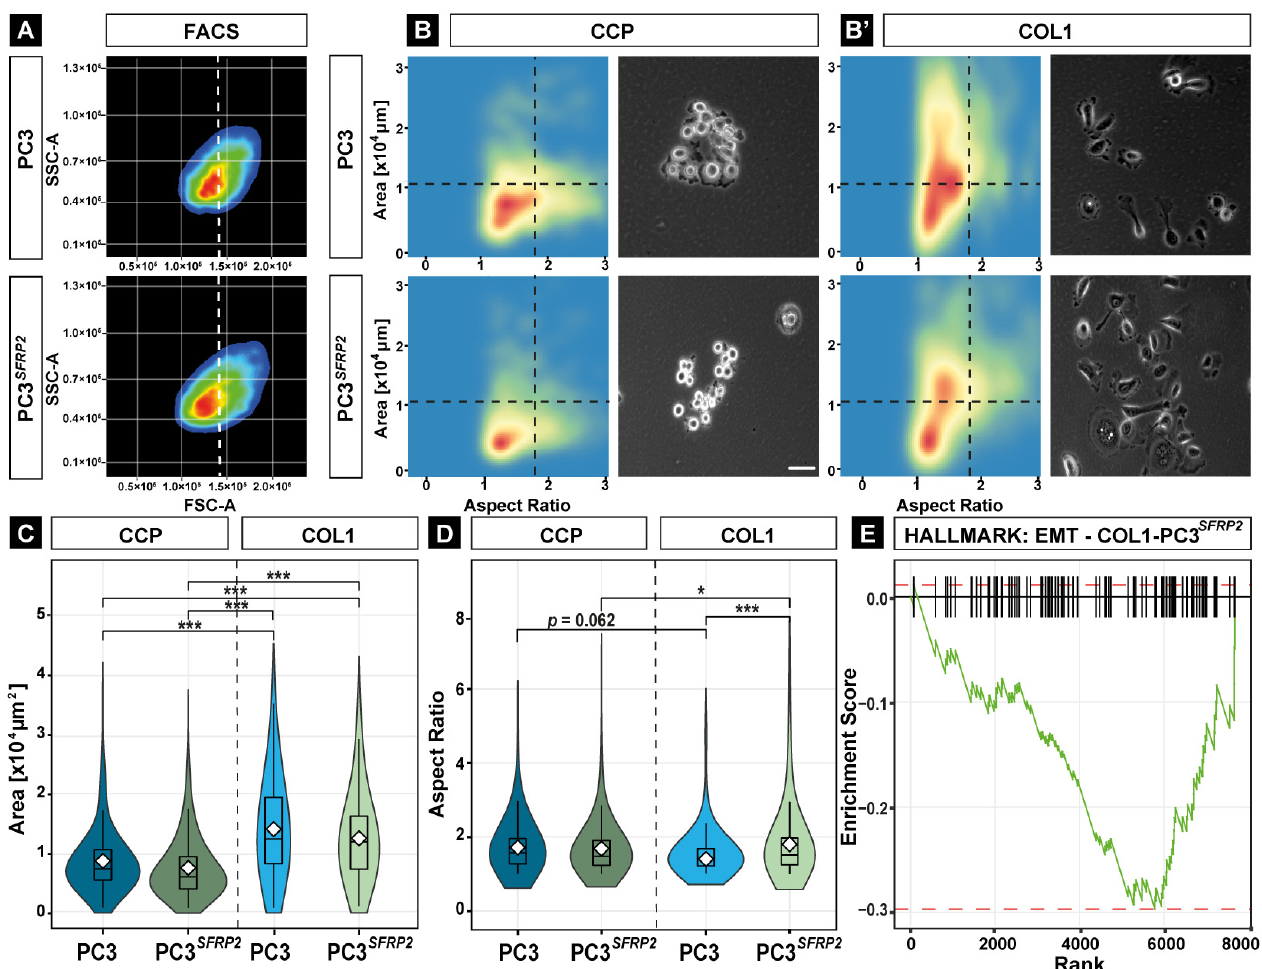
Figure 4. SFRP2 overexpression induces COL1-dependent EMT in PC3 cells. No morphological differences between PC3 and PC3 SFRP2 were observed in FACS analysis when cells were in suspension ( A ). On the CCP surface, PC3 cells are epithelial-like, while PC3 SFRP2 cells are more roundish ( B ). The COL1 surface induces an increase in cell size and elongation in both PC3 and PC3 SFRP2 ( B ′ ). Quantification of the cell morphology reveals that COL1 significantly increases cell size in PC3 SFRP2 cells ( C ) and elongation in COL1-PC3 SFRP2 cells ( D ). RNAseq analysis revealed that COL1-PC3 SFRP2 exhibited significant upregulation of the EMT pathway-related hallmark gene set when compared to CCP-PC3 SFRP2 . COL1-PC3 SFRP2 enrichment score < 0, CCP-PC3 SFRP2 enrichment score > 0 ( E